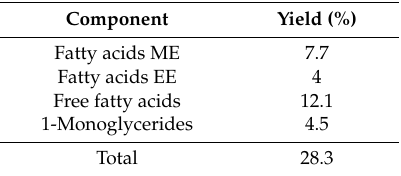
Table 2. Summary of the yield (%) of any class of fatty acids in the extract.